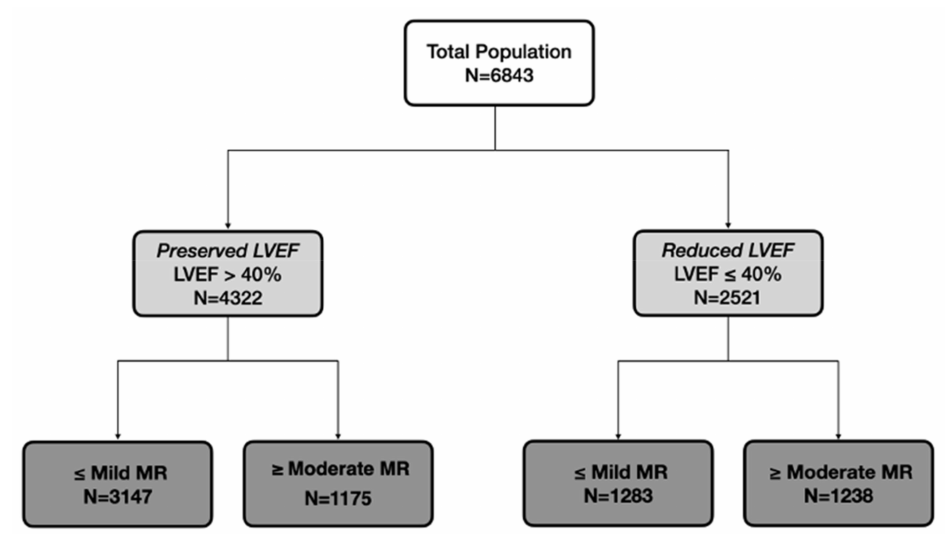
Figure 1. Patient population. LVEF = Left ventricle Ejection Fraction; MR = Mitral